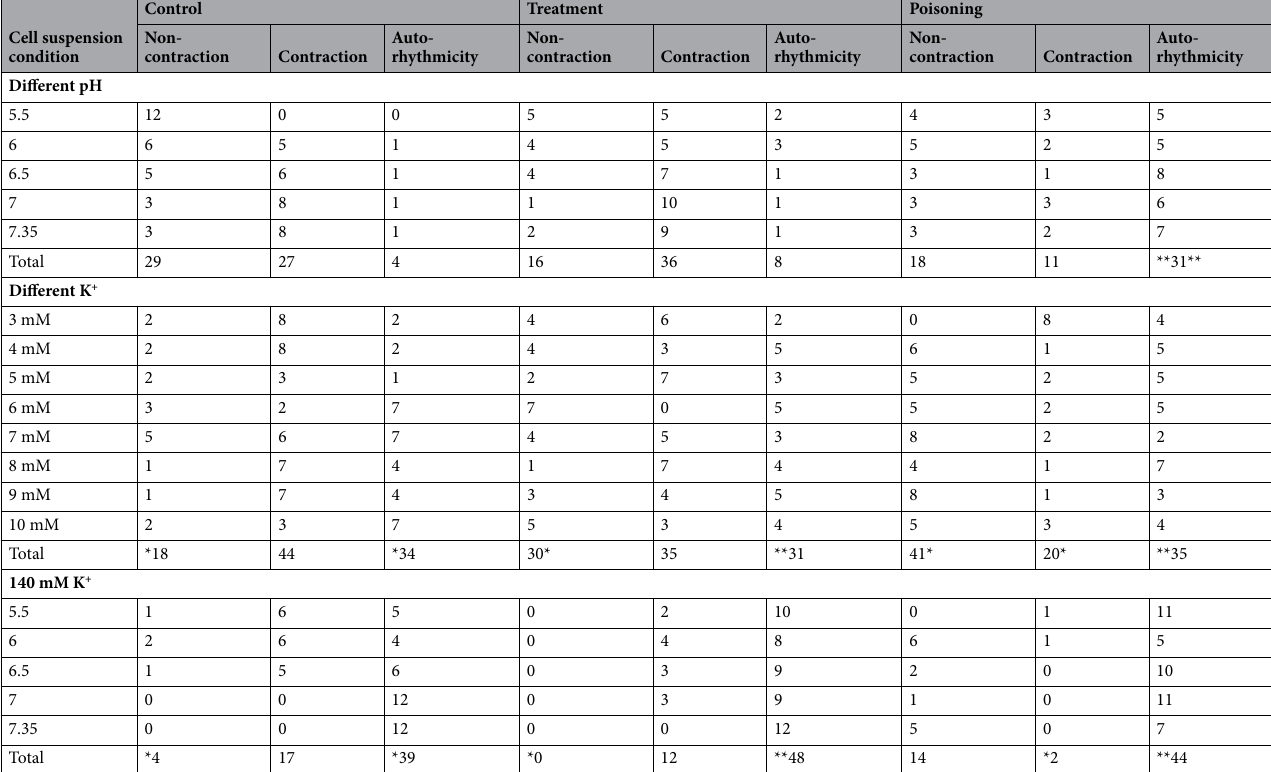
Table 1. The behavior of cardiomyocytes in the experiment (n = 12). A single symbol denote P < 0.05, double symbol denote P < 0.001. The symbol on the left of the total number is the comparison of the control group with different pH conditions and other groups; the symbol on the right side of the total number is the comparison of the treatment group and the poisoning group with the control group under different